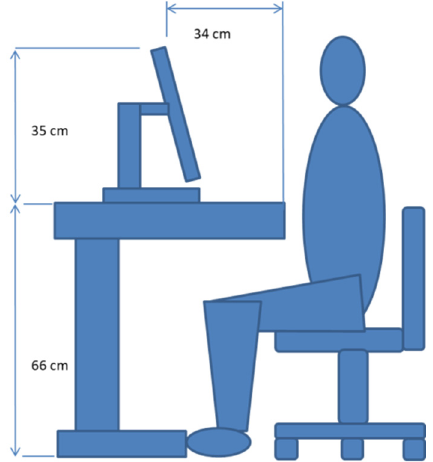
Figure 5. The apparatus set-up in this study. The screen was located on a 66 cm high desk and angled backward; the top edge of the screen was 35 cm from the desktop in the vertical direction, and the bottom edge of the screen was 34 cm from the desk edge near the participant. Participants sat on a chair and adjusted the seat height until they felt comfortable operating the apparatus.